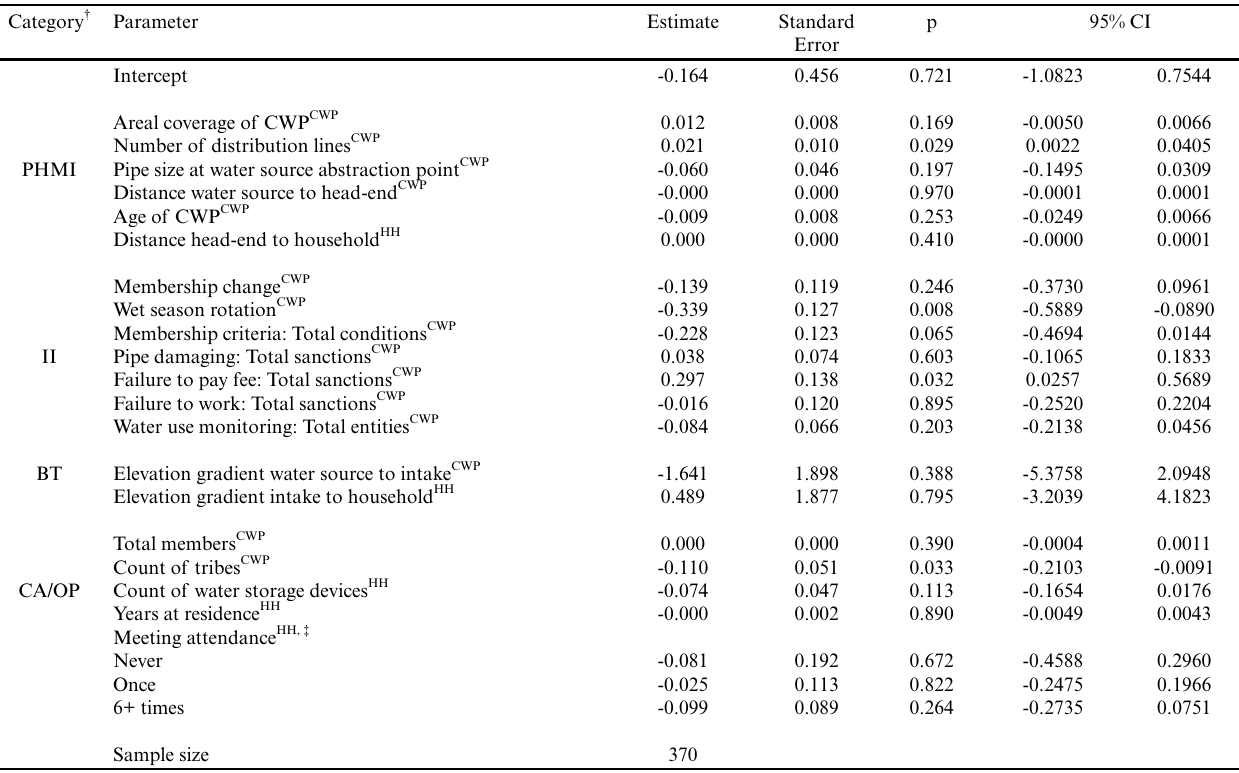
Table 8. Multilevel model results: CV of water